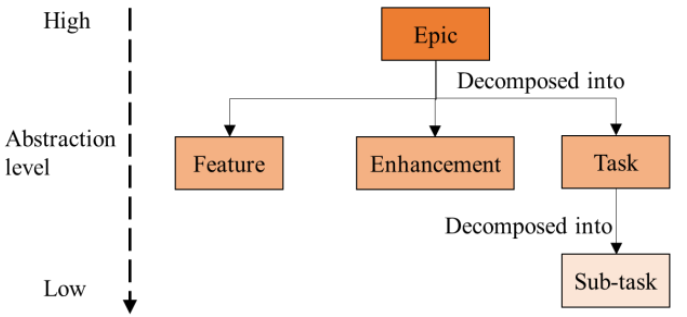
Figure 3. Requirements of different abstraction levels in JIRA and their decomposition